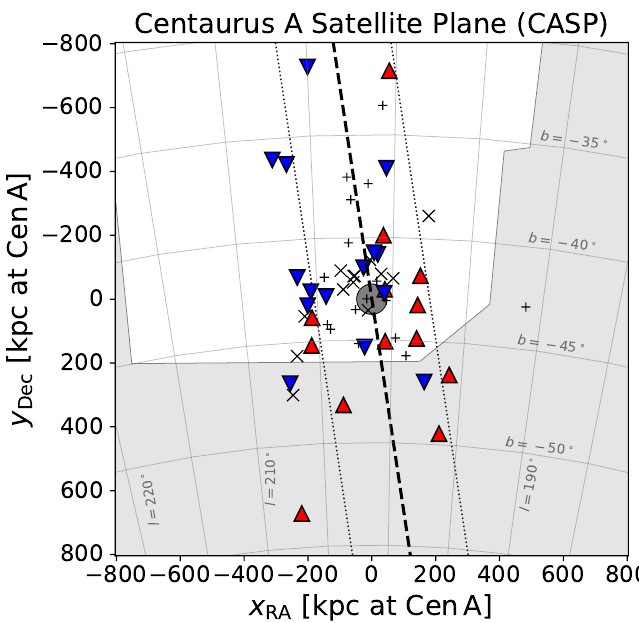
Figure 5. Distribution of dwarf galaxies around Centaurus A (dark grey circle in the center) as seen from the Milky Way, plotted similarly to Figures 2 and 4. Dwarf galaxies with known line-of-sight velocities are colored, and other dwarf galaxies with consistent distance measurements (large crosses) or satellite galaxy candidates (black plus signs) are also shown. The dashed line indicates the major axis of the on-sky satellite distribution, and the dotted lines show its root mean square